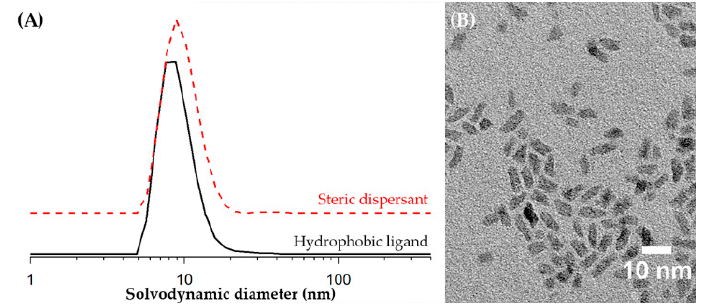
Figure 2. HfO 2 nanocrystals after the synthesis with tri- n -octylphosphine oxide. ( A ) Dynamic light scattering (DLS) analysis revealed a mean solvodynamic diameter of 10.2 nm in toluene, while the ligand exchange with a steric dispersant in 1-butanol resulted in a solvodynamic diameter of 10.7 nm. ( B ) TEM image indicating the nanorod-like morphology.